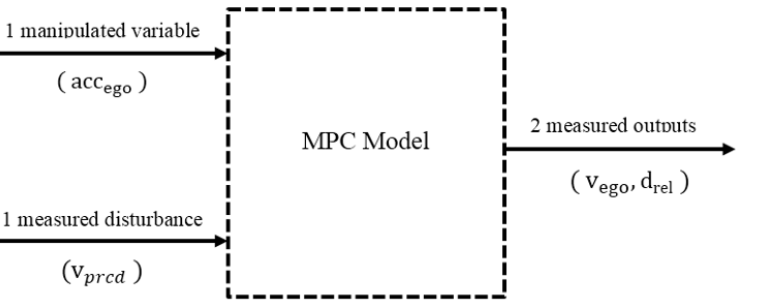
Figure 8. MPC plant model—inputs/outputs.